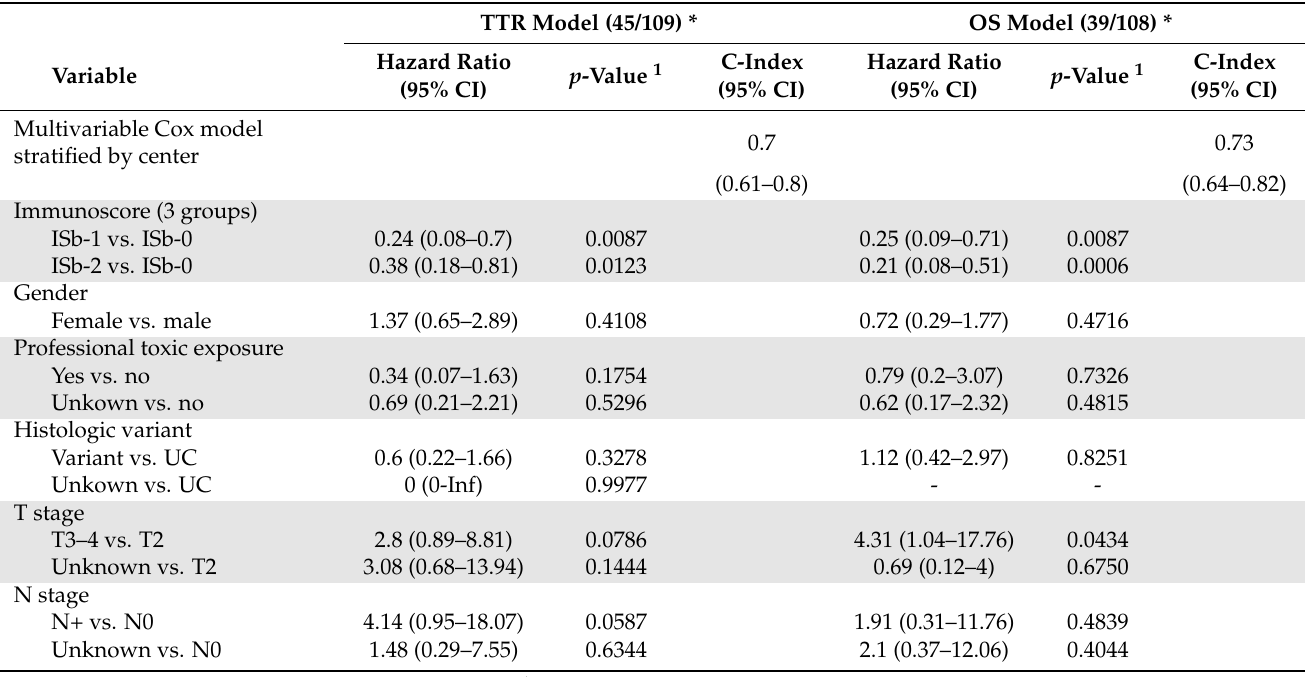
Table 4. Multivariable analysis immunoscore biopsy vs. clinical parameters for time to recurrence and overall